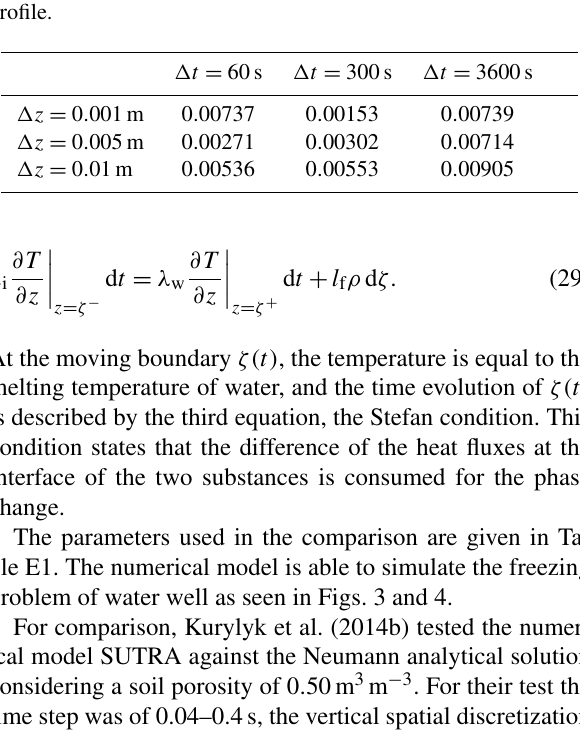
Table 2. Maximum error (m) of the freezing front position from the numerical solution with the NCZ algorithm for different space and time discretizations relative to the Neumann analytical solution. For the numerical solution the position of the freezing front has been reconstructed from the linear interpolation of the temperature